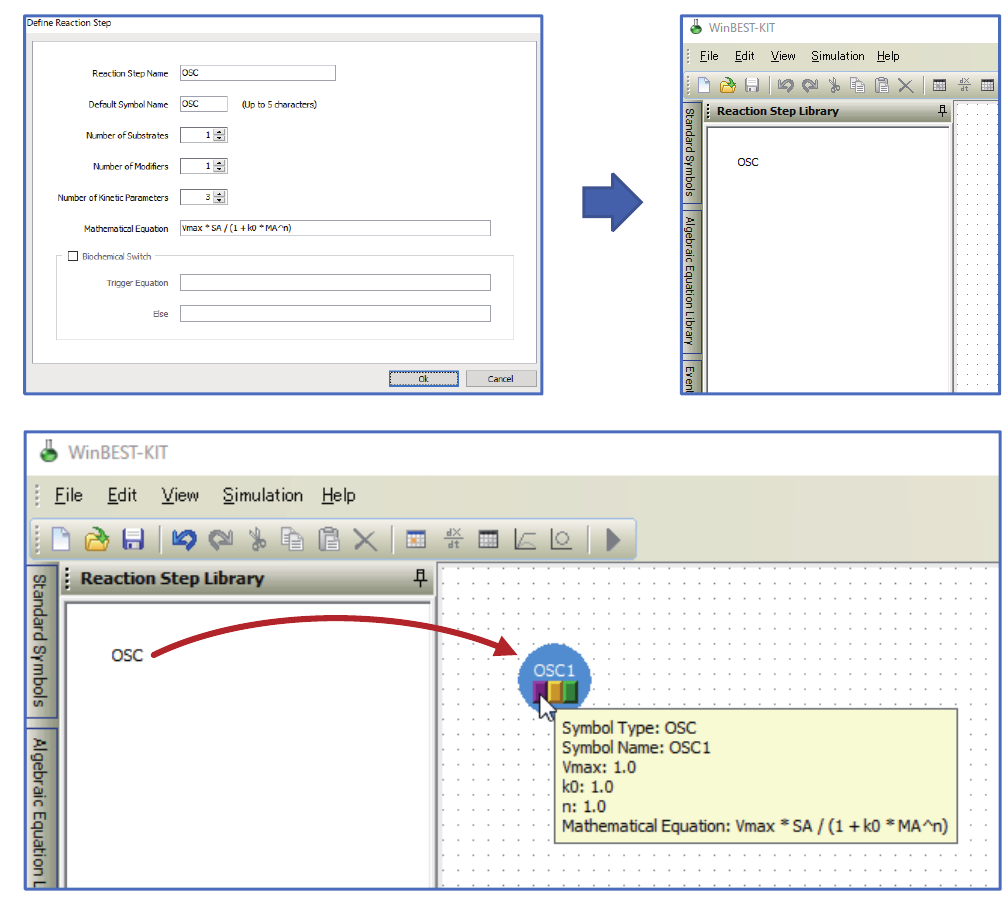
Figure 2. The kinetic equation labeled “OSC” can be registered in the symbol selection area in